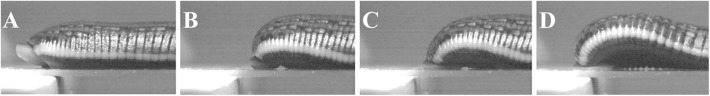
The adhesion process of the posterior sucker.A: the sucker bent down and the inner surface uncovered; B: the inner surface in contact with the substrate; C: the sucker stretched out along the radial direction and its thickness decreased; D: the ultimate morphology of the sucker (contact area is maximized while thickness is minimized).